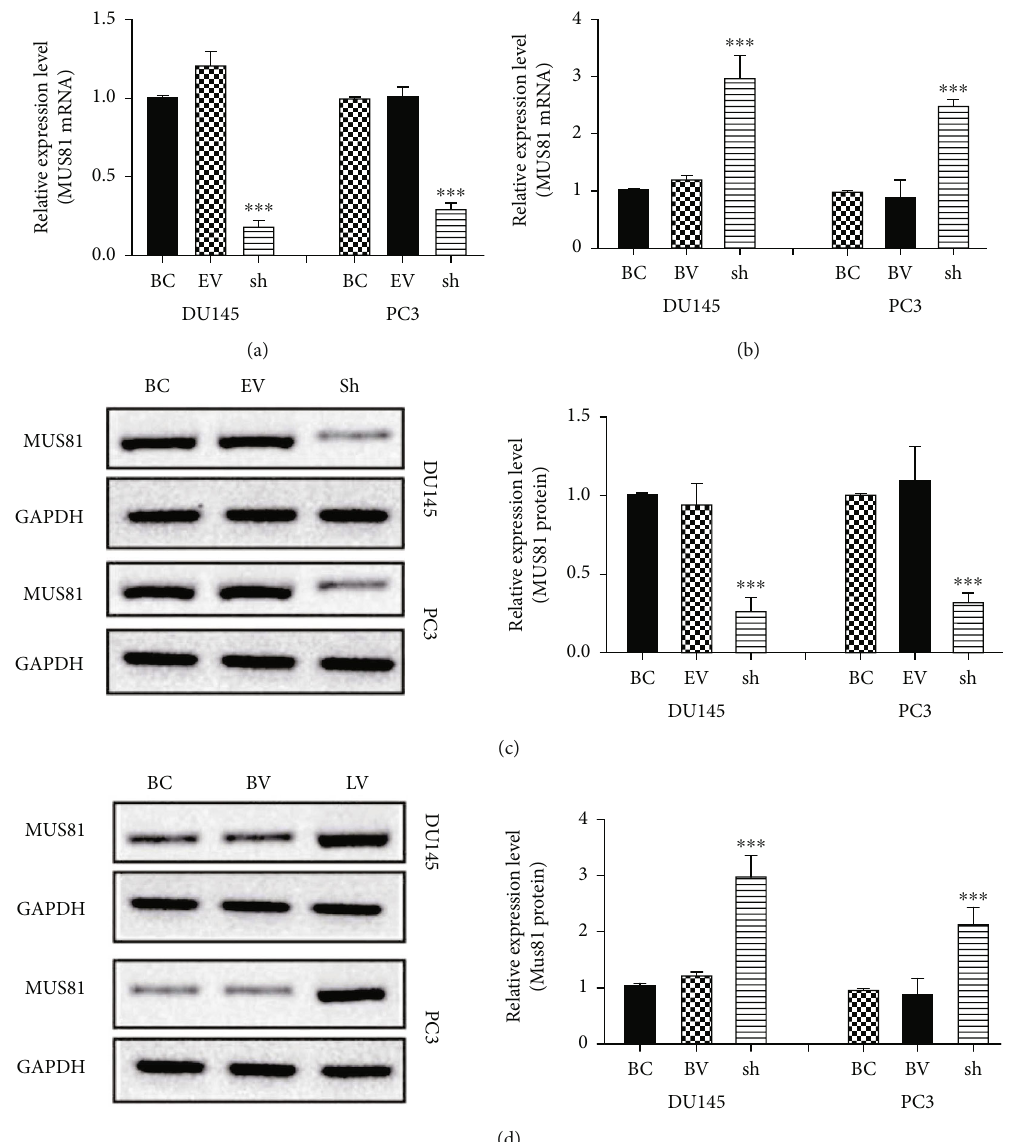
Figure 3: After lentivirus transfection, the expression of MUS81 in DU145 and PC3 cells. (a) The relative levels of the MUS81 mRNA transcripts after silencing MUS81. (b) The relative levels of MUS81 protein after silencing MUS81. (c) The relative levels of the MUS81 mRNA transcripts after overexpressing MUS81. (d) The relative levels of MUS81 protein after overexpressing MUS81. ∗∗∗ P < 0 : 001 versus the no-load virus group (EV) cells and negative control group (BV)